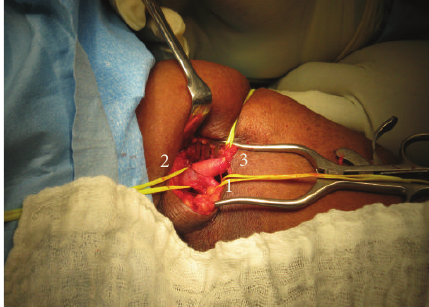
Figure 3: Operative photograph of the dissection in the antecubital fossa demonstrating the proximal (1) and distal (2) brachial artery. The anastomosis (3) is seen clearly and the PTFE graft is seen coursing proximally to the axillary vein.